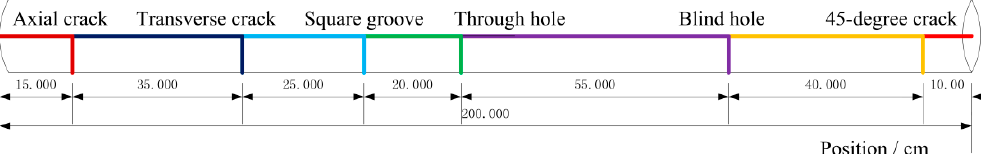
Figure 7. Laboratory experiment of pipeline inspection. ( a ) Picture of experimental setup, 1—Global positioning system, 2—Data Acquisition System, 3—Acquisition Card, 4—Magnetic Sensor; ( b ) Figure 8. Locations of defects in the laboratory pipeline. Laboratory scheme design; ( c ) Field test; ( d ) Defect location.